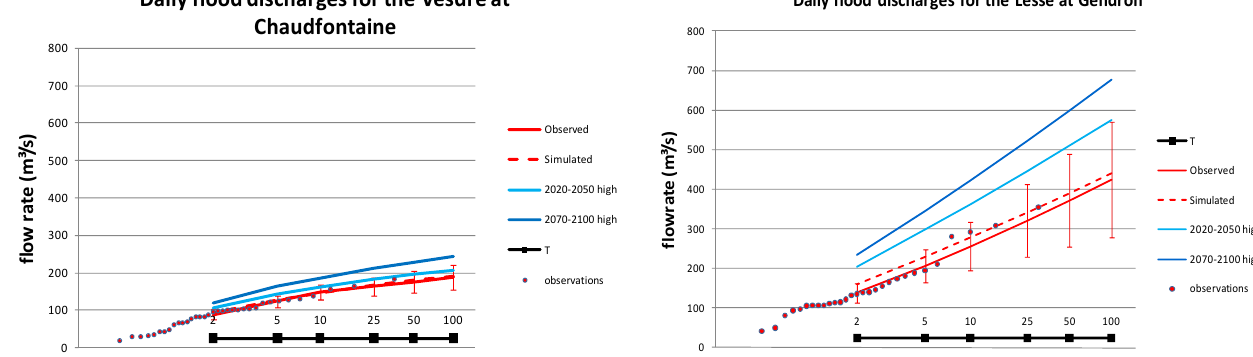
1 Fig. 5. Daily flood discharges for the Vesdre at Chaudfontaine (upper panel) and the Lesse at Gendron (lower panel) for different return period ( T ). The 95% confidence interval of the reference period is plotted as red brackets. Dots represent maximum observed daily discharges, the red line represents the fitted distribution of the observed values.